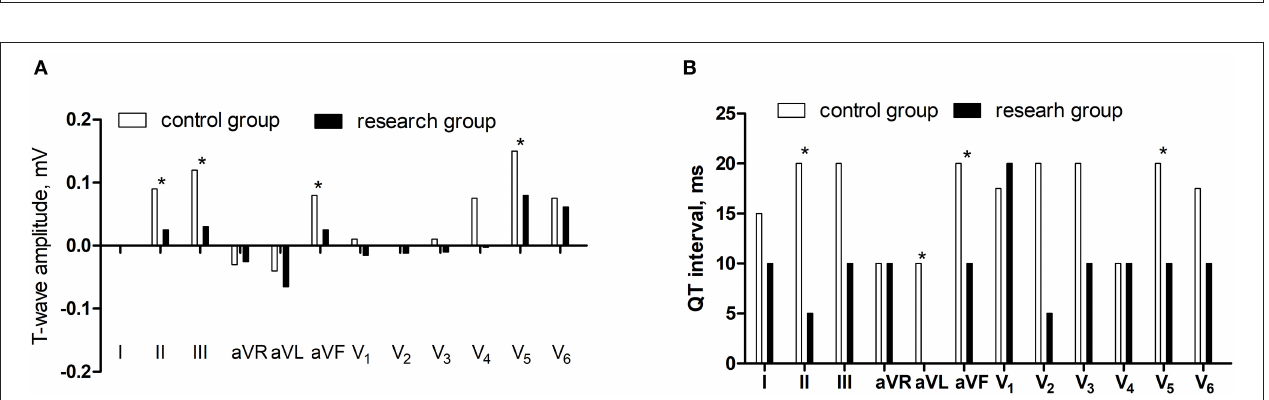
FIGURE 3 | The comparisons of differences of T-wave amplitude and QT interval between supine and orthostatic ECG. (A) The differences of T-wave amplitude. (B) The differences of QT interval.* P < 0.05.